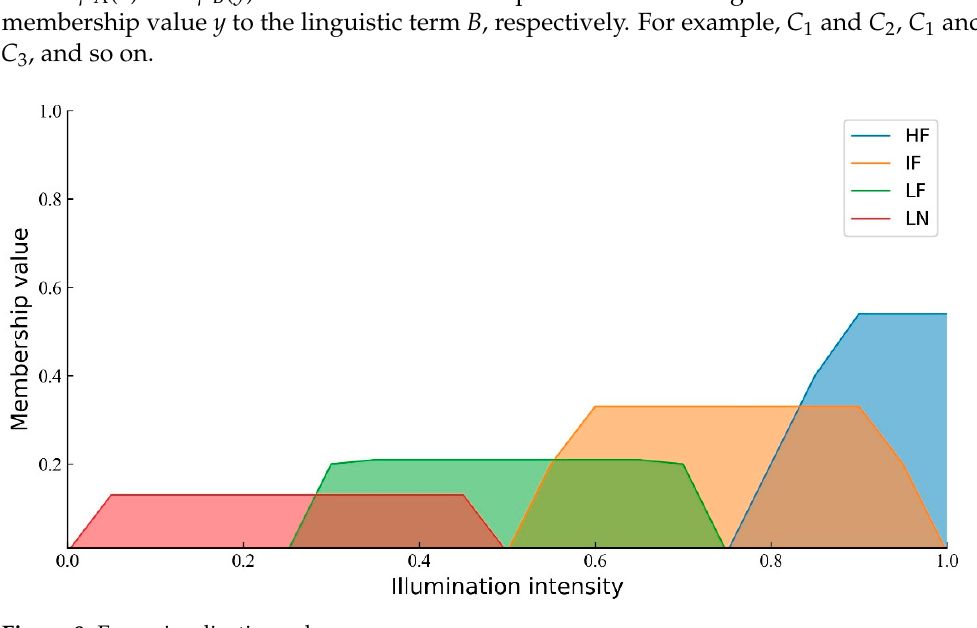
Figure 7. Triangular membership functions.